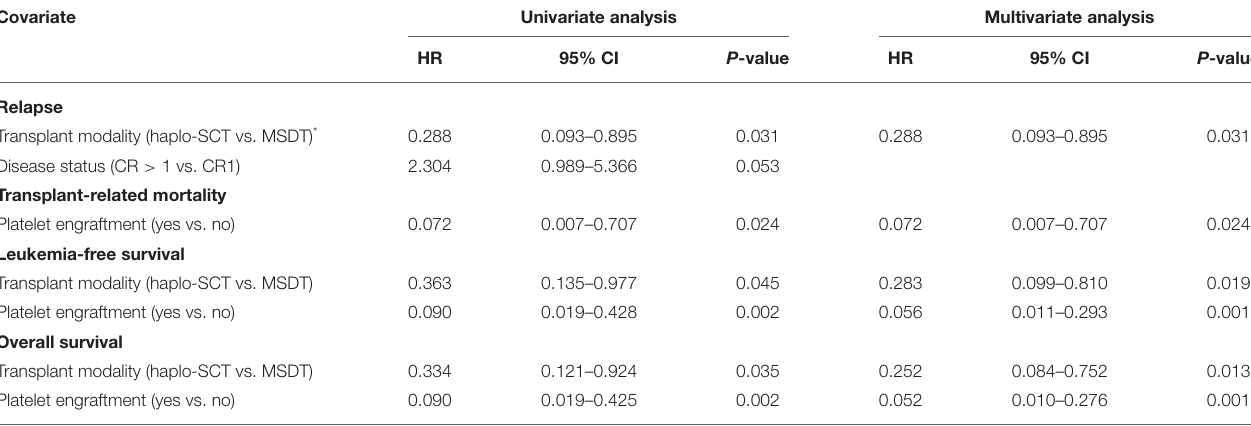
TABLE 5 | Multivariate analysis of factors associated with outcomes of Ph positive ALL patients with positive pre-transplantation MRD who underwent allo-SCT ( n = 54).